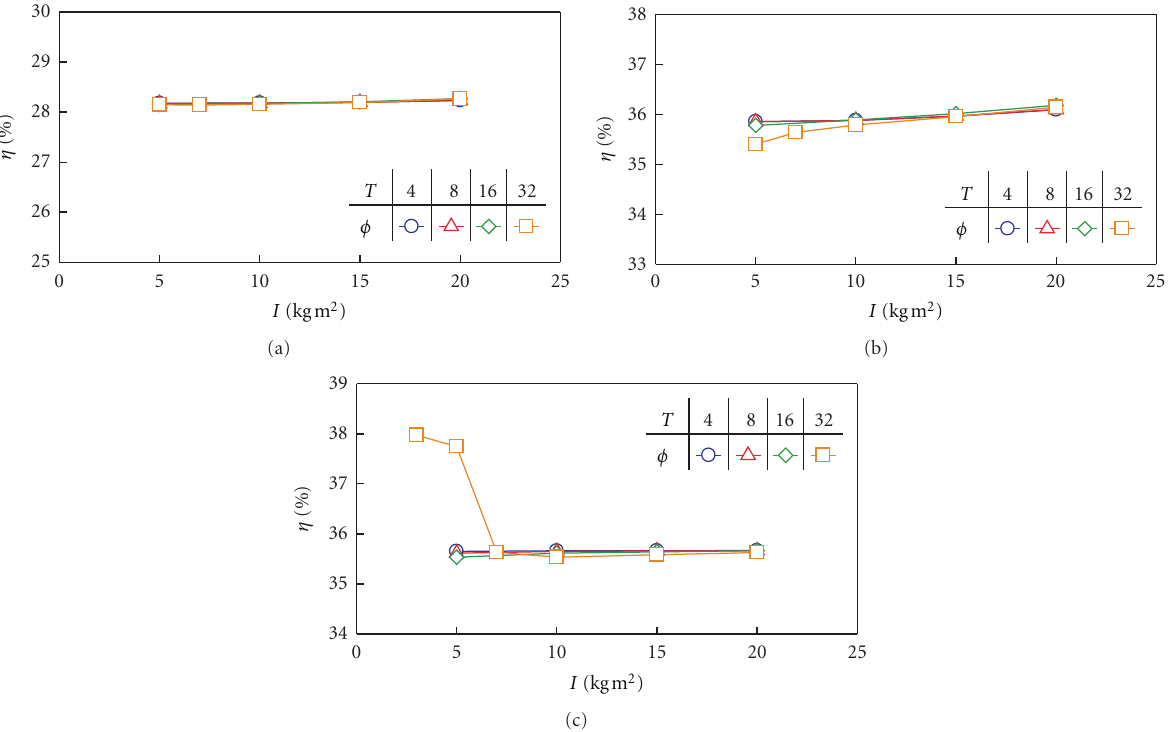
Figure 17: Energy e ffi ciency, η , for mean wind speed (a) V 0 = 7, (b) V 0 = 10, and (c) V 0 =